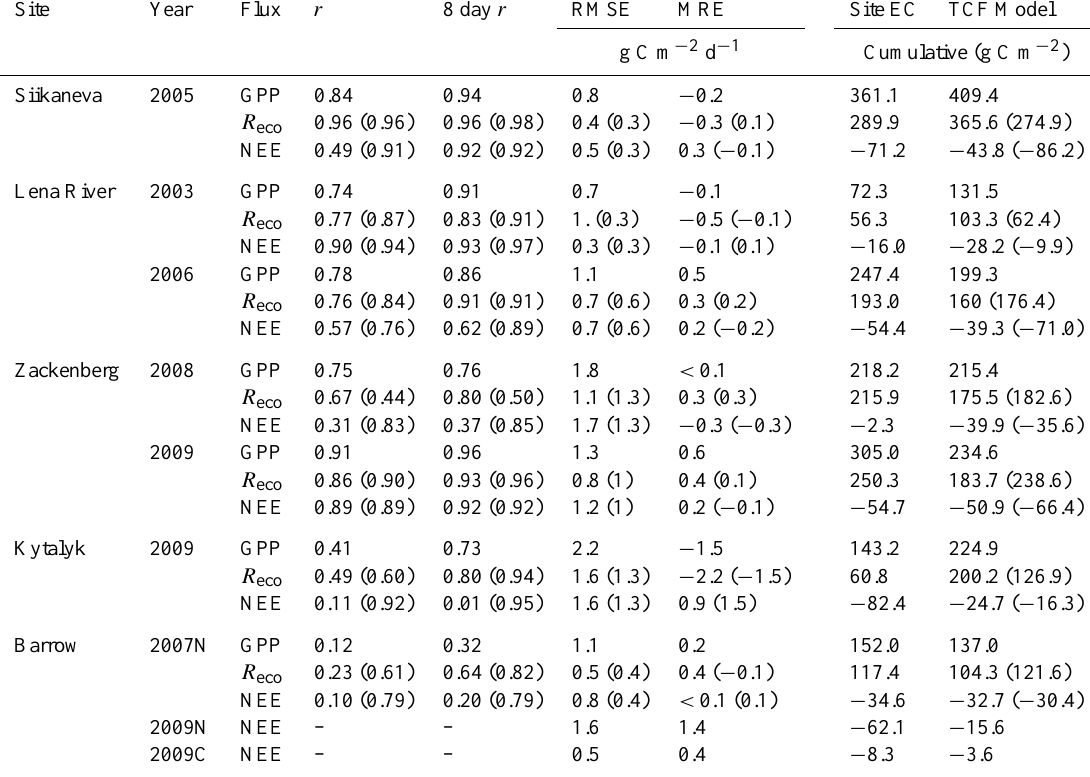
Table 2. Tower EC CO 2 records and TCF modeled gross primary production (GPP), ecosystem respiration ( R eco ) and net ecosystem ex- change (NEE) derived using in situ information (in parentheses) or satellite remote sensing and reanalysis inputs. The Pearson correlation coefficients ( r ) are significant at a 0.05 probability level, excluding Kytalyk 2009 NEE ( r ≤ 0.11, p ≥ 0.17) and Barrow 2007N GPP and NEE ( r < 0.1, p ≥